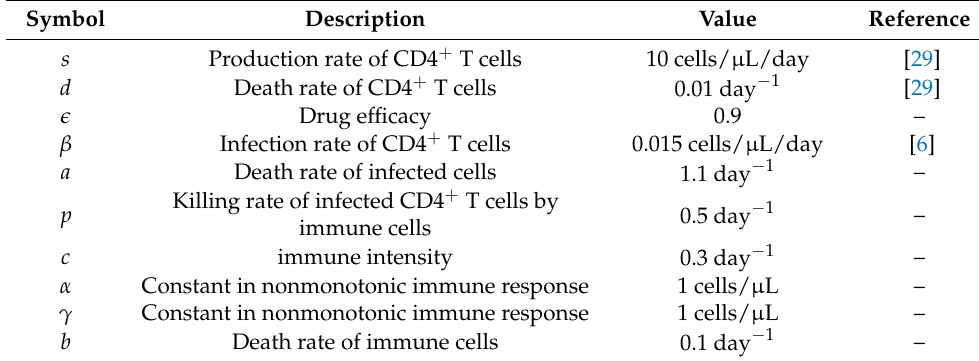
Table 3. Description and values of the parameters in model